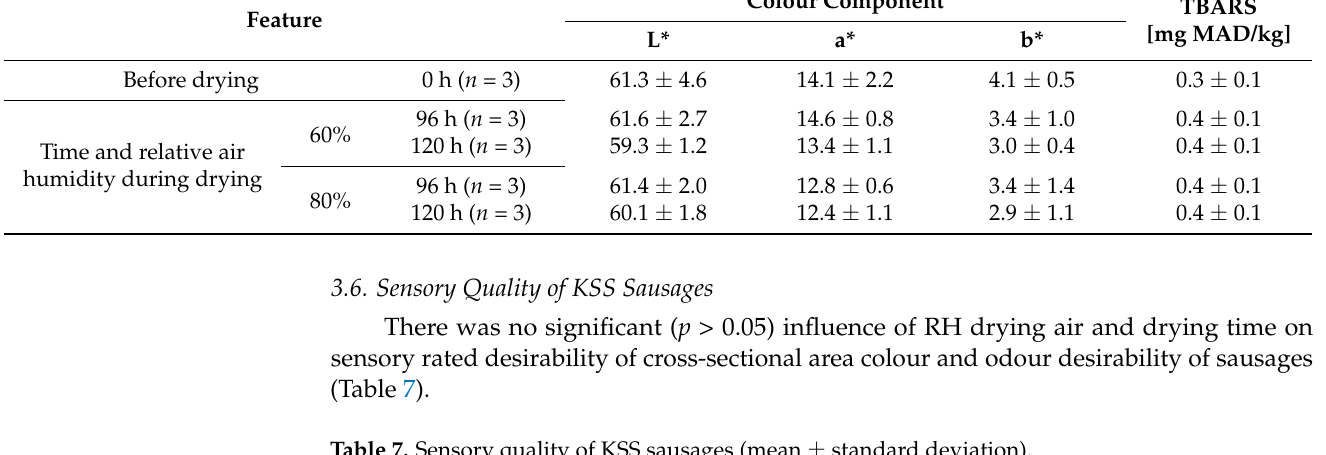
Table 7. Sensory quality of KSS sausages (mean ± standard